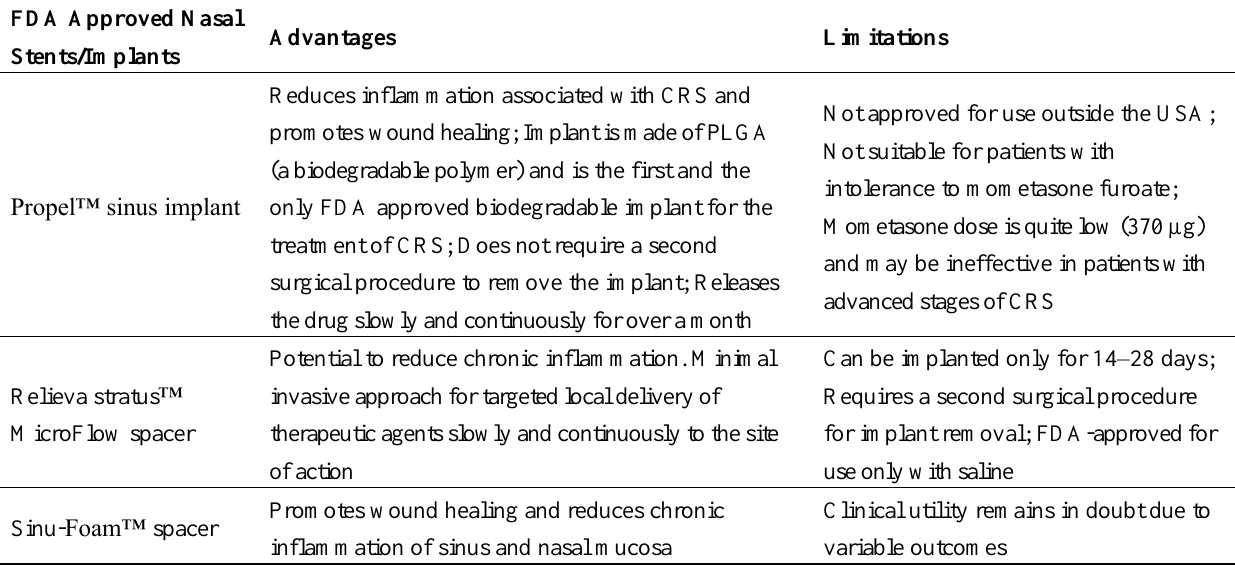
Table 1. Comparison of the major advantages and limitations of Propel™ sinus implant, Relieva stratus™ Microflow spacer and Sinu-Foam™